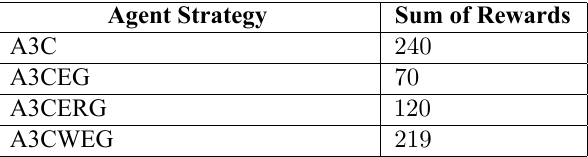
Table 4. The average sum of rewards in the last 100 registered train- ing episodes over six simulations. We register one episode every other one hundred